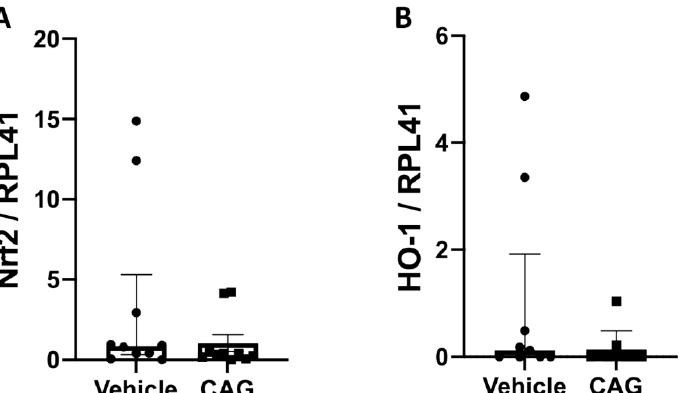
Figure 7. Effect of CAG on aneurysmal oxidative stress. ( A ) Relative mRNA levels of nuclear factor erythroid 2–related factor (Nrf2) (n = 9/9) and ( B ) relative mRNA levels of Heme oxygenase (HO)-1 (n = 9/9) in the aneurysm tissue. All values are median ± interquartile range. All RNA data is normalized to RPL41 mRNA levels. In more advanced AAAs, calcifications become significant [33]; therefore, the effect of CAG on calcifications was examined by Von Kossa’s calcium deposit staining. Calcifications were present in 4 out of 7 AAA samples in the vehicle treated group, while no calcifications were detected in 7 out of 7 in the CAG-treated group (Figure 8A, B, p = 0.018).